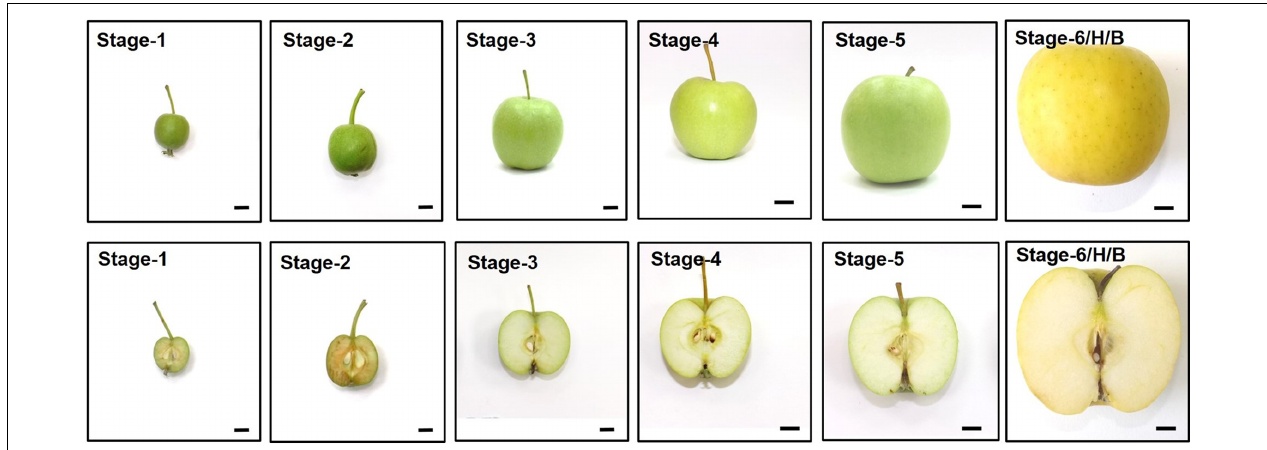
FIGURE 4 | Developmental stages of “Golden Delicious (GD)” apple. Fruit at each stage were collected according to their size, and similar stages were also collected for “Anna” and “Galaxy.” Bar = 1 cm. See Supplementary Figure S1 for size and weight of the fruit from each stage of all three cultivars.